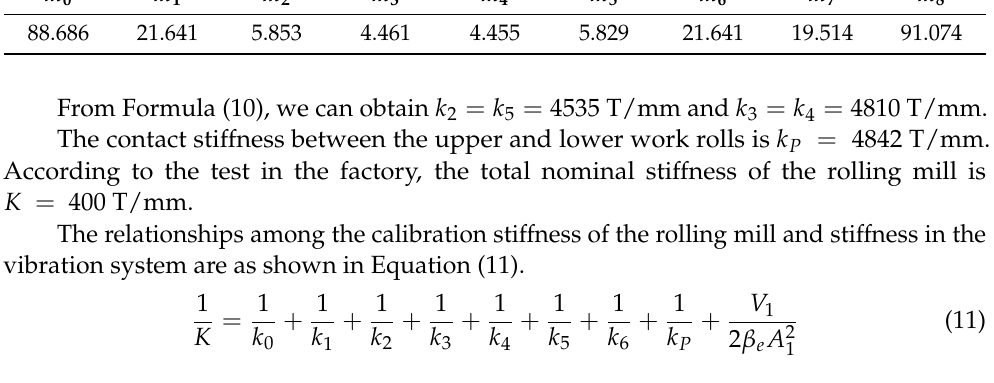
Table 1. Parameters of equivalent mass of rolling mill (T). m